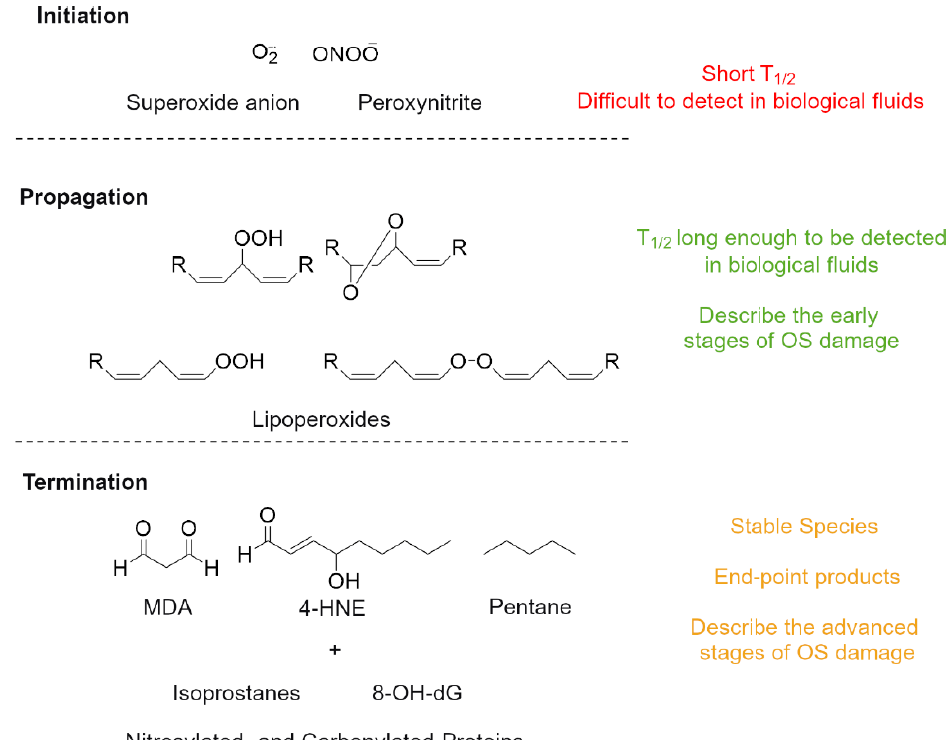
Figure 5. Schematic representation of the oxidative-stress reactive chain with highlighted repre- sentative chemical species at the initiation, propagation, and termination stages.